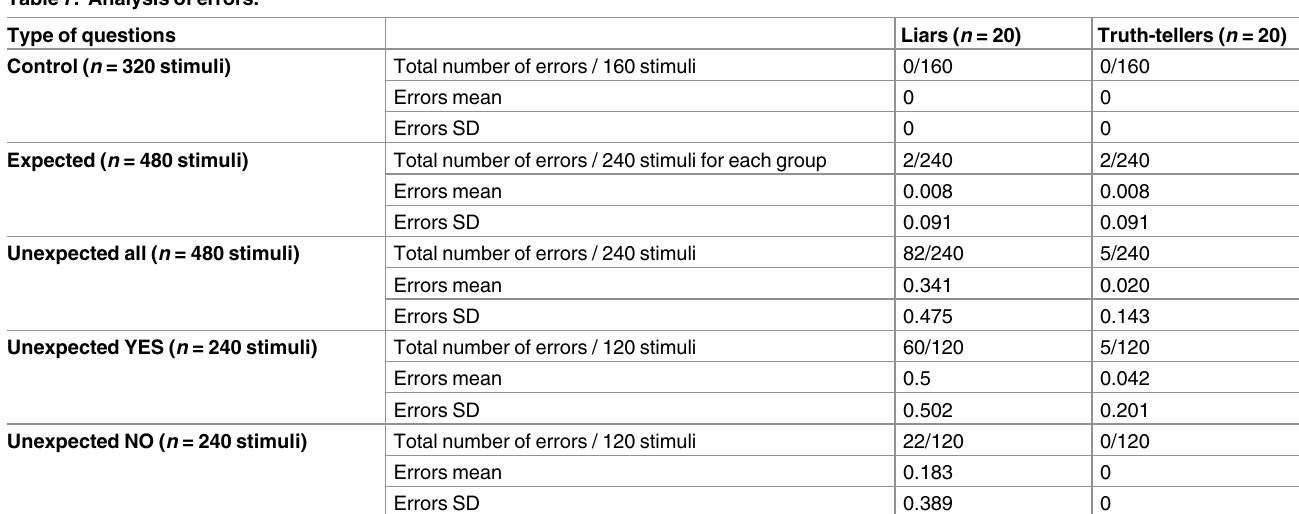
Table 7. Analysis of